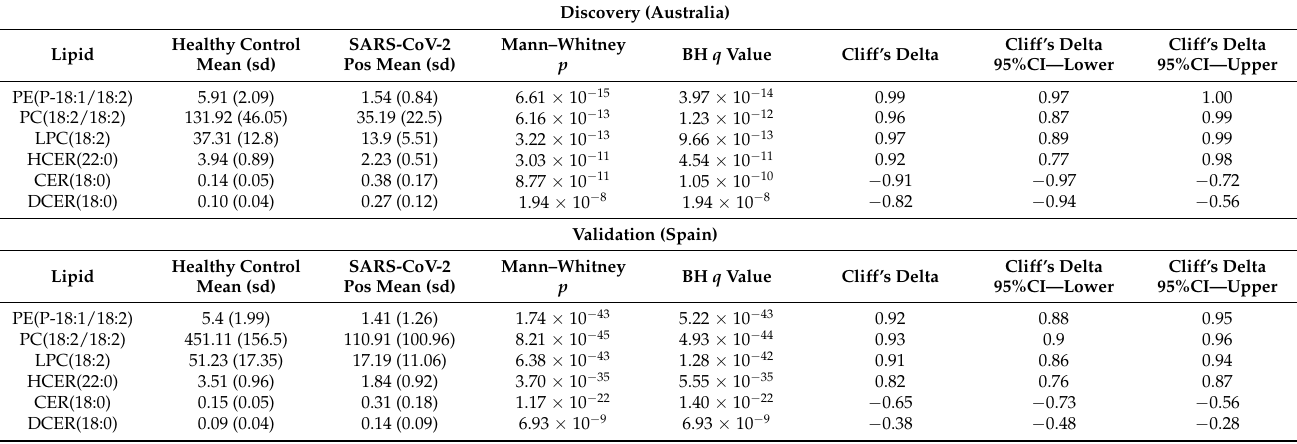
Table 2. Univariate analysis of the lipid classifier panel. Six candidates were selected, with four decreasing and two increasing in SARS-CoV-2. Univariate statistics for the 275 lipids that were significant in the OPLS-DA (Figure 2) can be found in Table